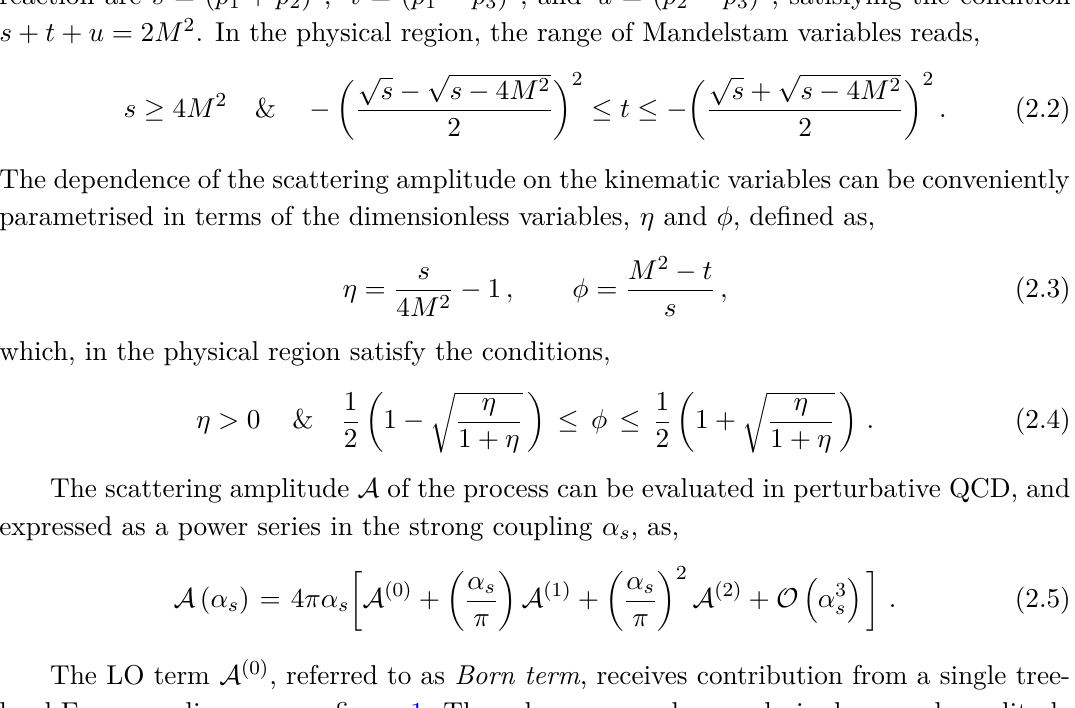
Figure 1 . Tree-level Feynman diagrams for the process q ¯ q → Q ( q ), whilst thick ones indicate a heavy quark ( Q ); curly lines correspond to gluons. reaction are s = ( p